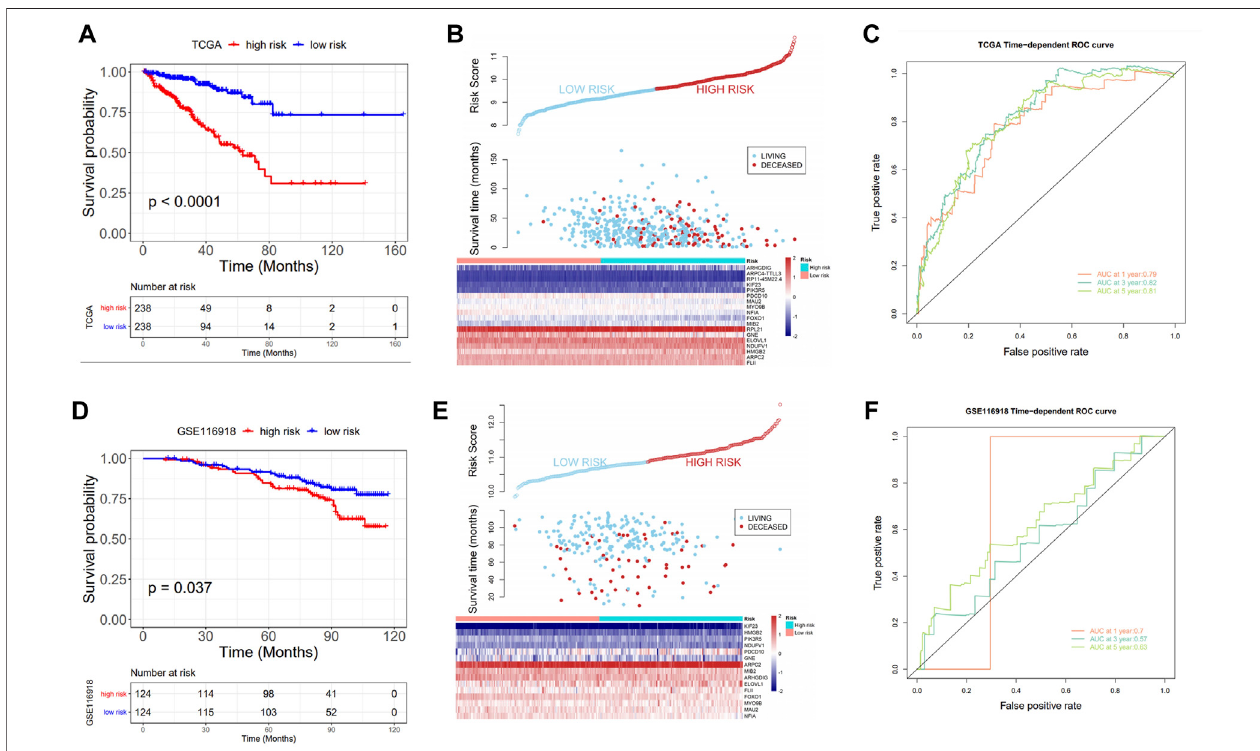
FIGURE4| Prognosticvalueoftheriskmodel. (A) KMcurve:upperpart:theprobabilityofsurvivalatdifferenttimesinthehigh-andlow-riskgroups;lowerpart:the numberofcasesinthehigh-andlow-scoregroupsatdifferenttimes; (B) Tripleplot:upperpart:riskscoresforthehigh-andlow-riskgroups;middlepart:survivaltimeof thelivinganddeceased cases;lowerpart: geneexpressioninthehigh-andlow-scoregroups; (C) ROCanalysis:assesstheAUCvaluesforOSpredictiveef fi cacyofrisk scores; (D – F) Prognostic model validation in GSE116918: KM curve, triple plot, and ROC